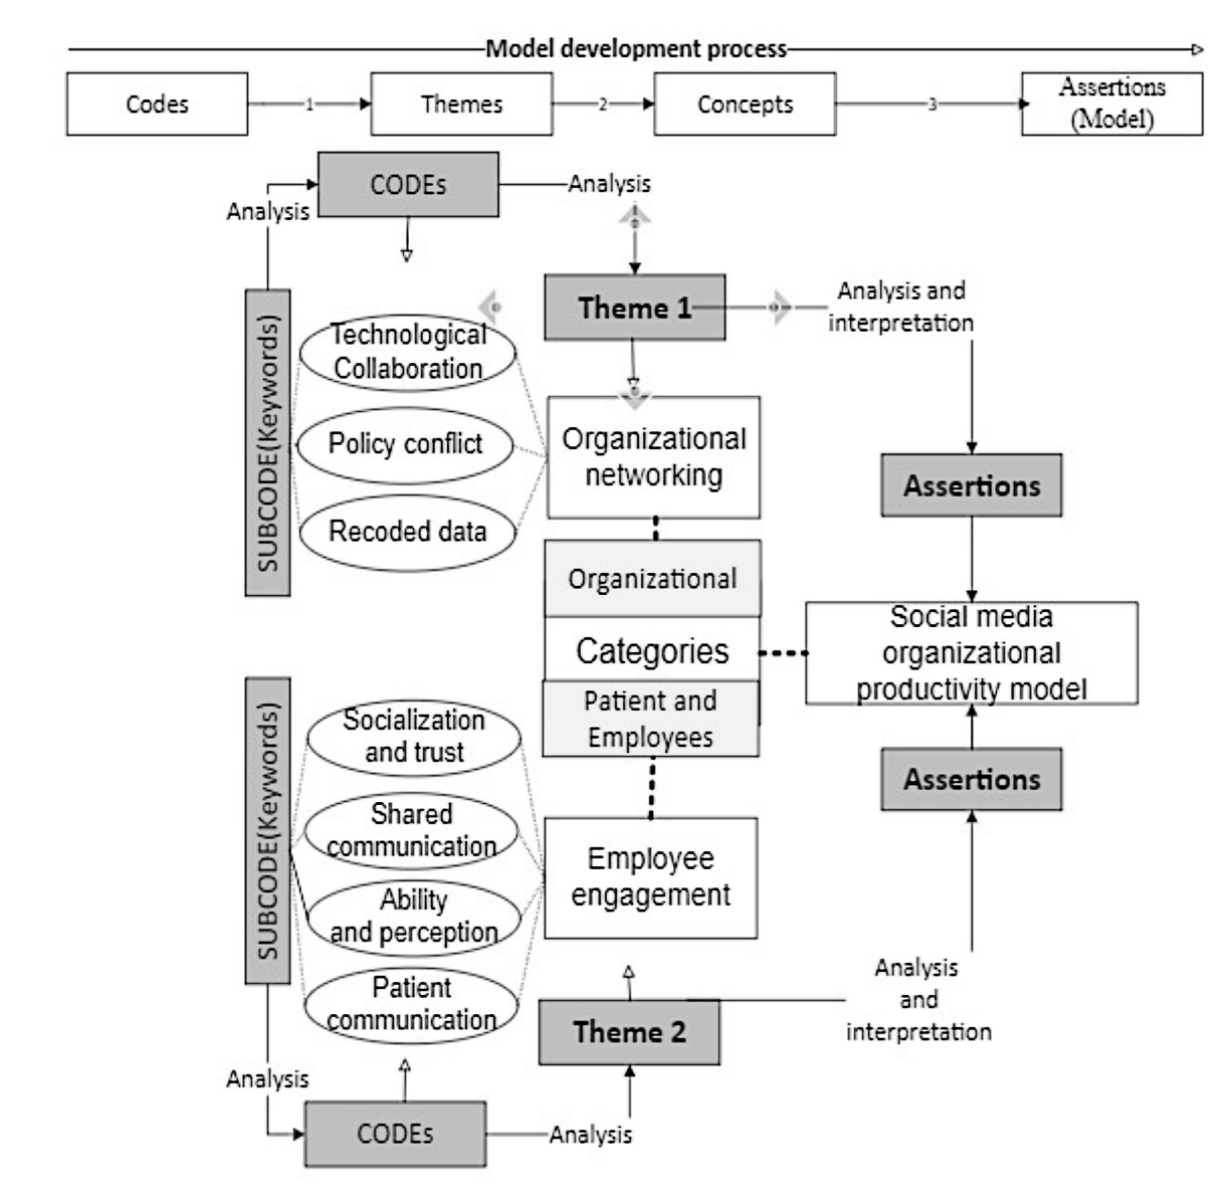
Figure 2. Thematic analysis